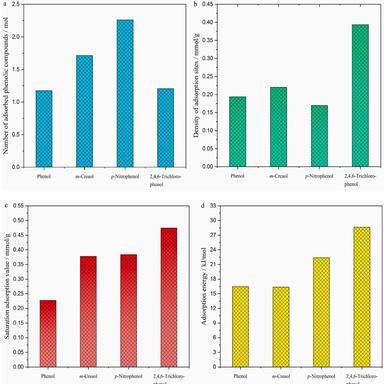
Fitting parameters of the statistical physics monolayer adsorption model. (a) number of phenolic compounds adsorbed per surface functional group; (b) densities of adsorption site; (c) adsorption capacities; (d) adsorption energy.